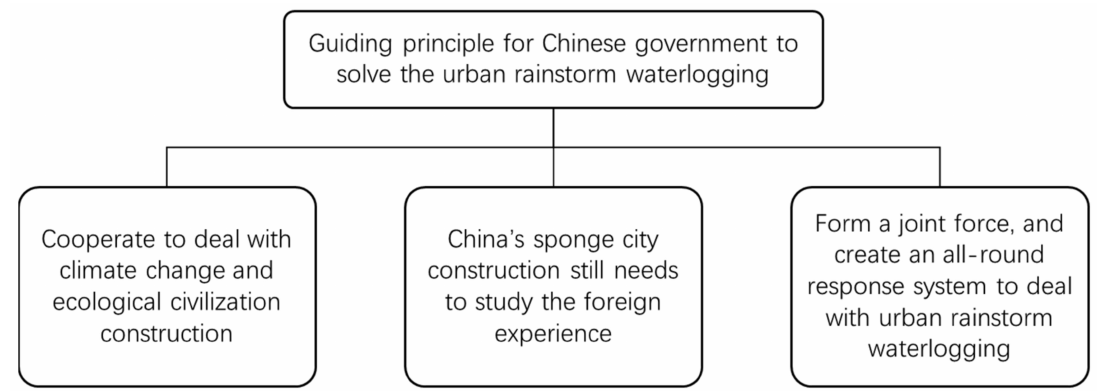
Figure 4. Guiding principles for the Chinese government to solve urban rainstorm